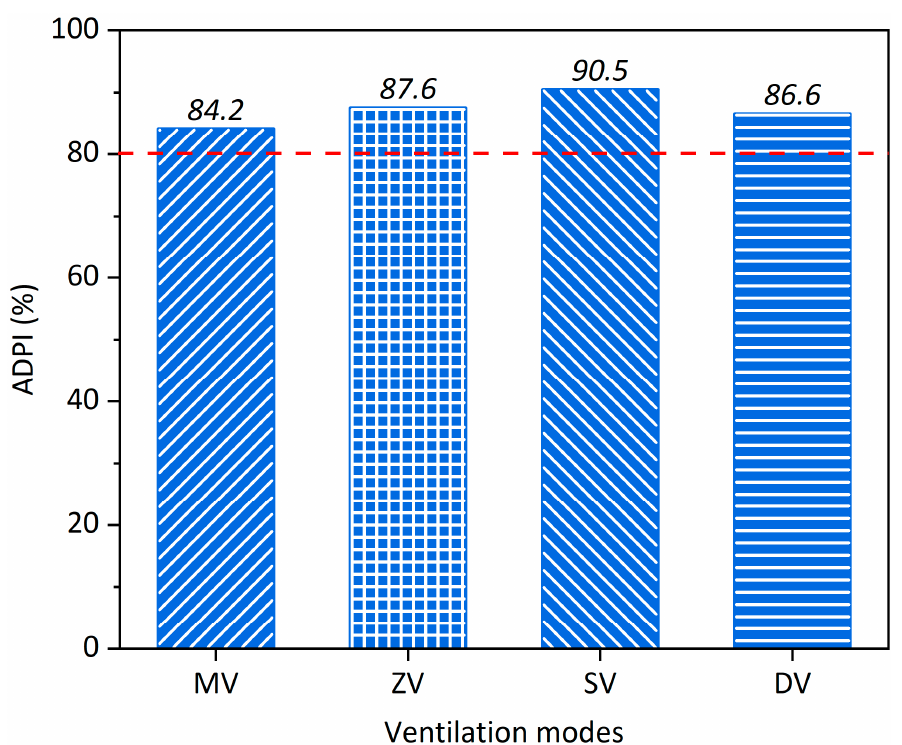
Figure 5. Calculation of ADPI values for different ventilation modes of mixing ventilation (MV), zone ventilation (ZV), stratum ventilation (SV) and displacement ventilation (DV).